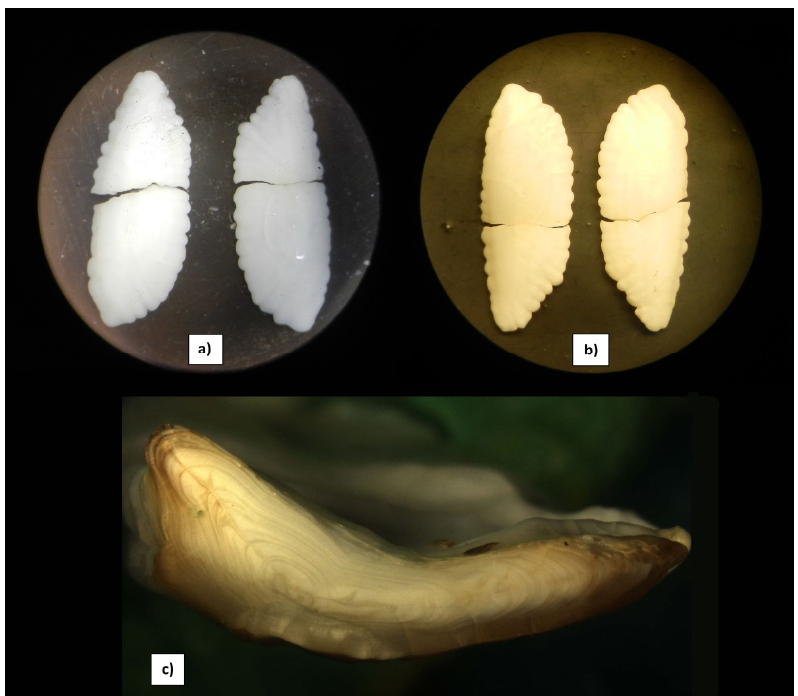
Figure 4. Walleye pollock Gadus chalcogrammus whole sagittal otoliths of from the Kara Sea ( a , b ) and sagitta cross-section of the specimen from the Barents Sea ( c ). Table 4. Composition of CO1 haplotypes in the studied walleye pollock Gadus chalcogrammus samples. Numbers of sam- ples correspond to Table 2. No. Sample